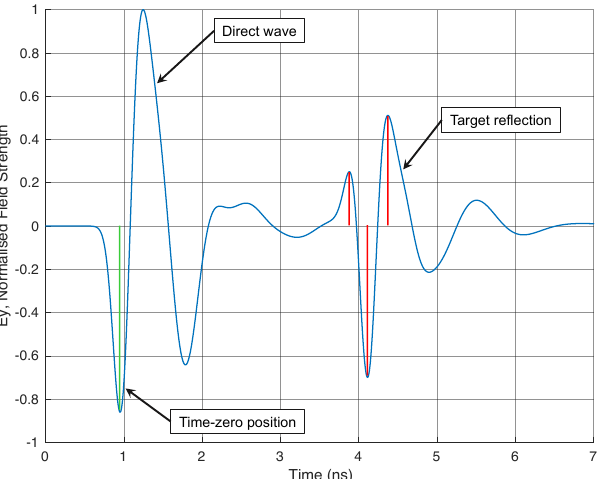
Figure 1. Time-zero is positioned on the first peak of the direct wave (green line). The two way travel time is calculated from the time-zero position to the average time of the three peaks (Perfect Electric Conductor (PEC) target response—red